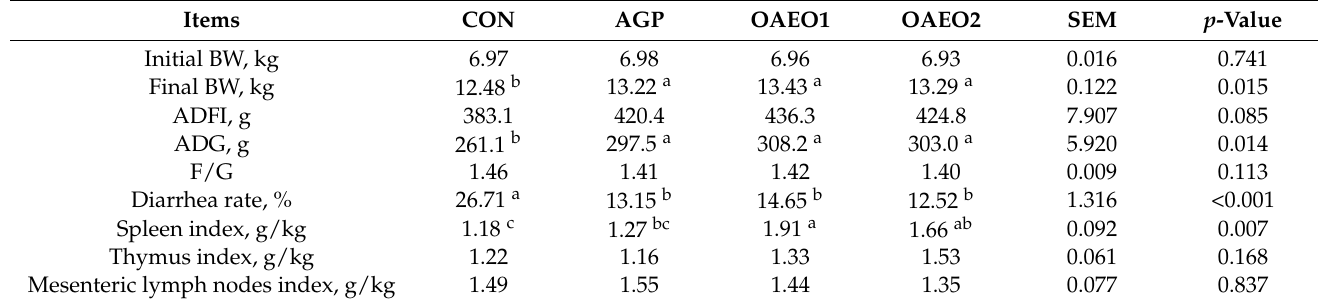
Table 1. Effect of OAEO on growth performance, diarrhea rate and immune organ indices of weaned piglets.